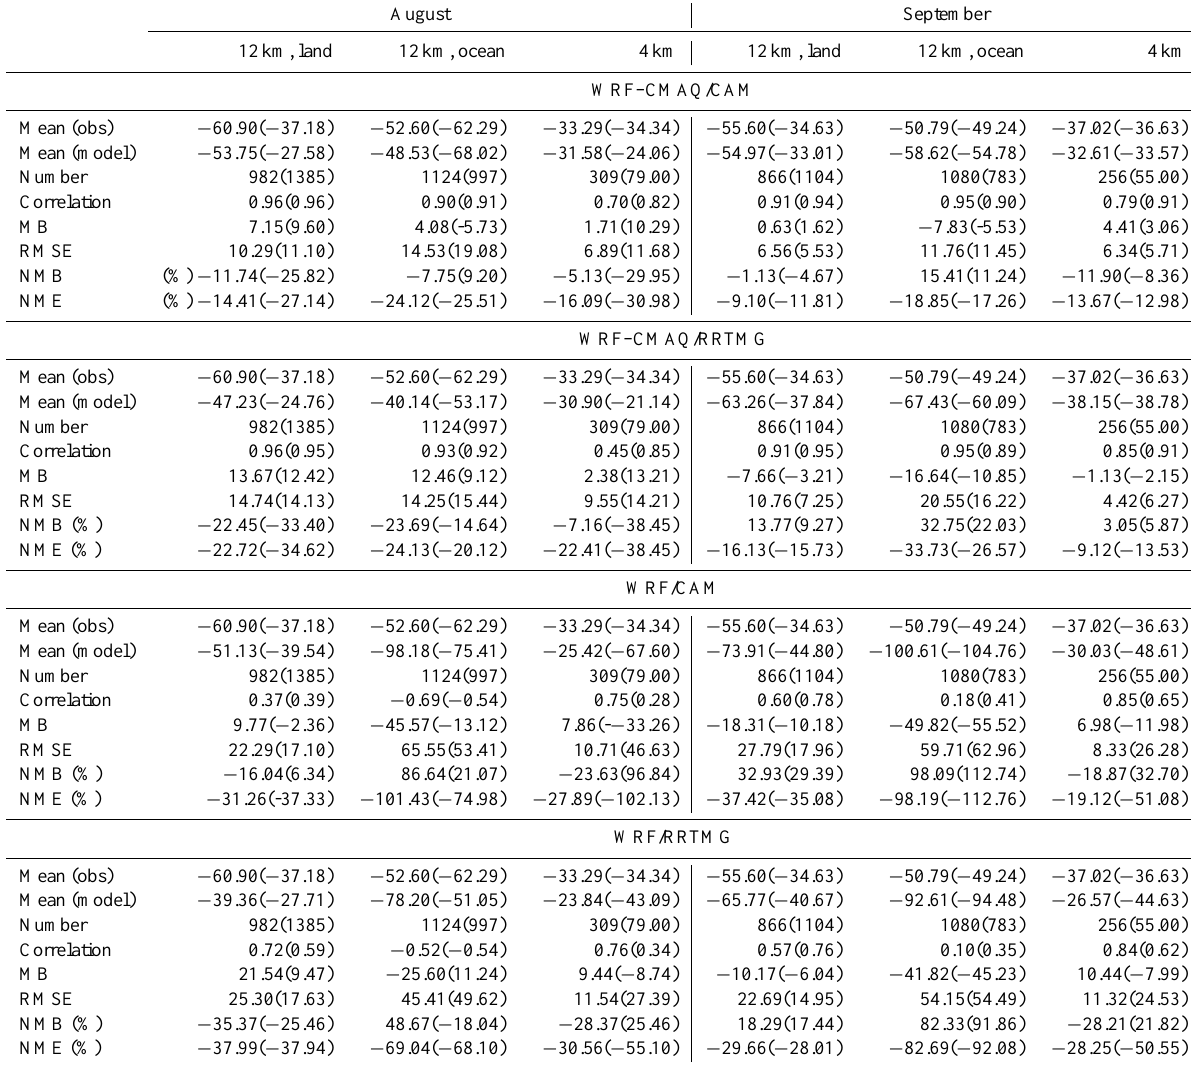
Table 9. Comparison of observation and models (WRF–CMAQ/CAM, WRF–CMAQ/RRTMG, WRF/CAM and WRF/RRTMG) for monthly SWCF (Wm − 2 ) over the land and ocean of the eastern US and the western US (in parentheses) of the CONUS from 12km resolution simulations and over eastern Texas from the 4km resolution simulations (the results in parentheses are from the 12km resolution simulation) in August and September of